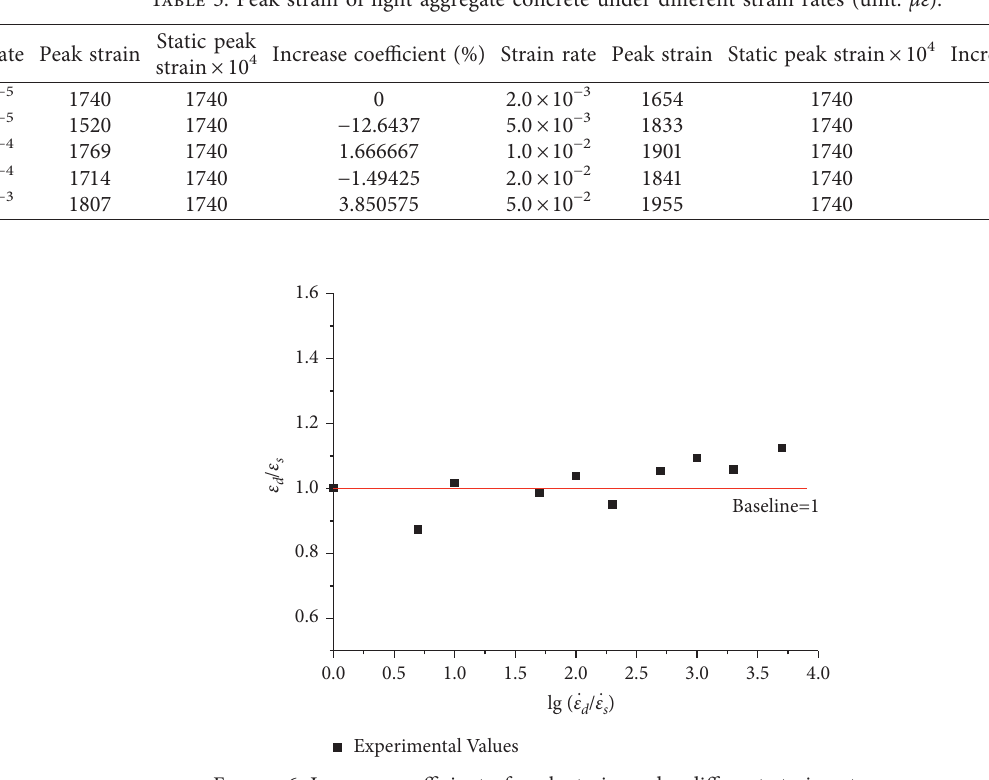
Figure 5: Increase coefficient of elastic modulus of lightweight aggregate concrete under different strain rates. Table 5: Peak strain of light aggregate concrete under different strain rates (unit: με ).